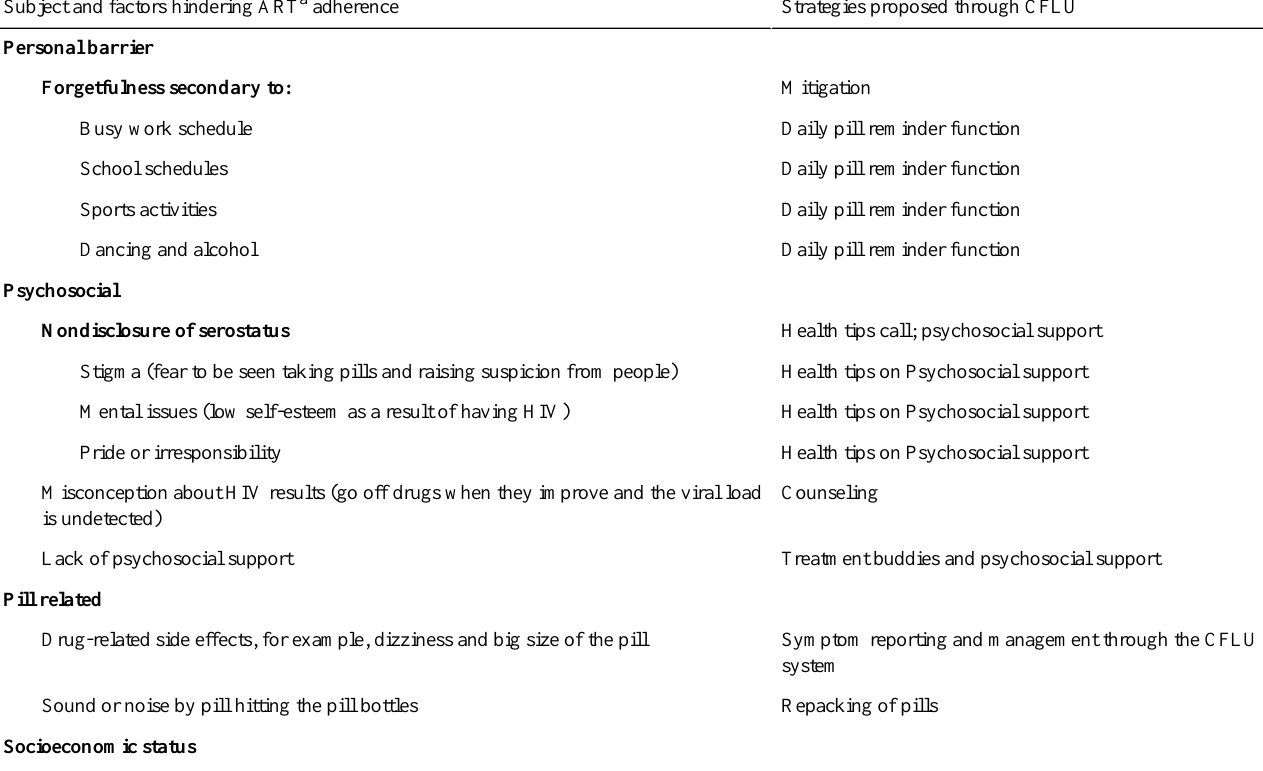
Table 3. Suggestions and adherence mitigation strategies from young adults through the Call for Life Uganda (CFLU) system.